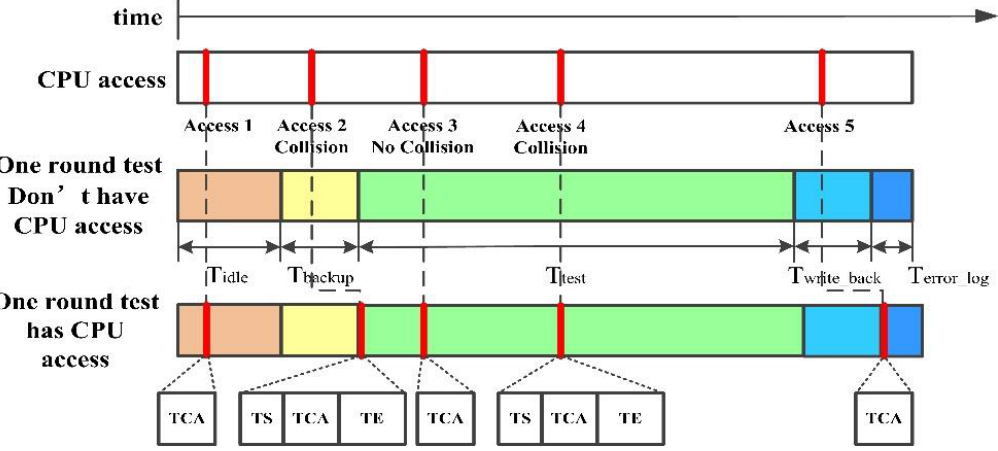
Figure 7. The timeline of access collision processing.